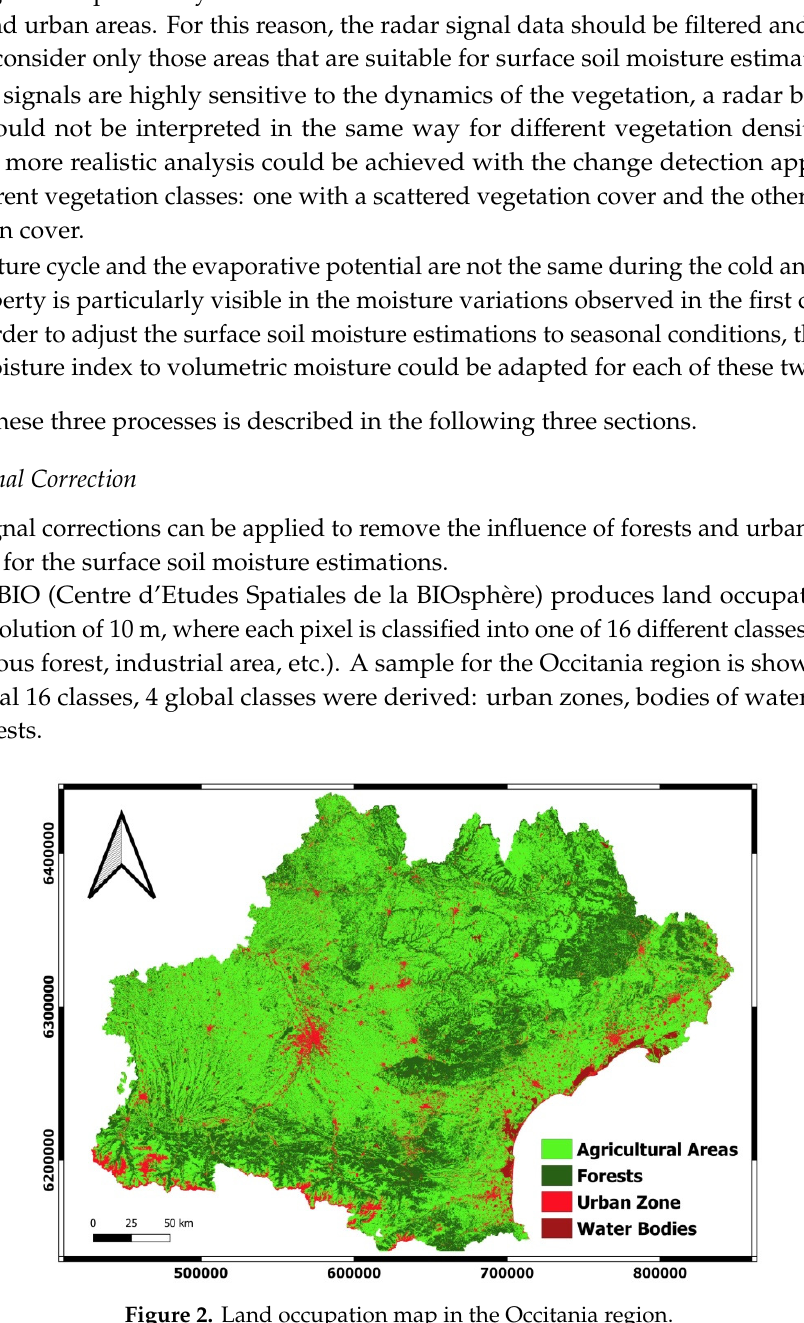
Figure 2. Land occupation map in the Occitania region.